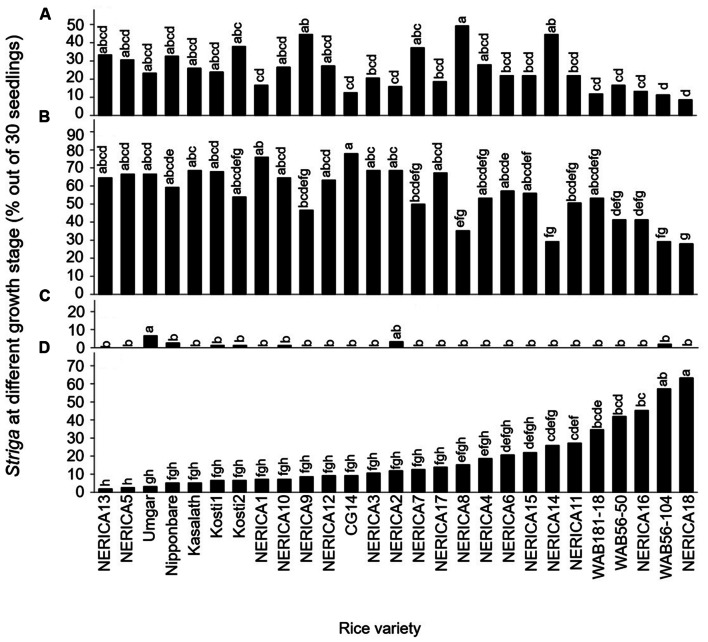
Percentage out of 30 seedlings of S. hermonthica at stage (A) I, failure to attach to the root due to a lack of haustorium formation (Figure 1a); (B) II, successful attachment but no shoot elongation (Figures 1b–d); (C) III, shoot necrosis after reaching the four or more leaf pairs stage (Figures 1e,f); and (D) IV, successful parasitism with healthy shoots (Figures 1g,h) on the roots of 27 rice varieties in the first rhizotron experiment at 21 DAI. Means followed by a common letter are not significantly different by Tukey’s HSD test in each growth stage (p < 0.05).